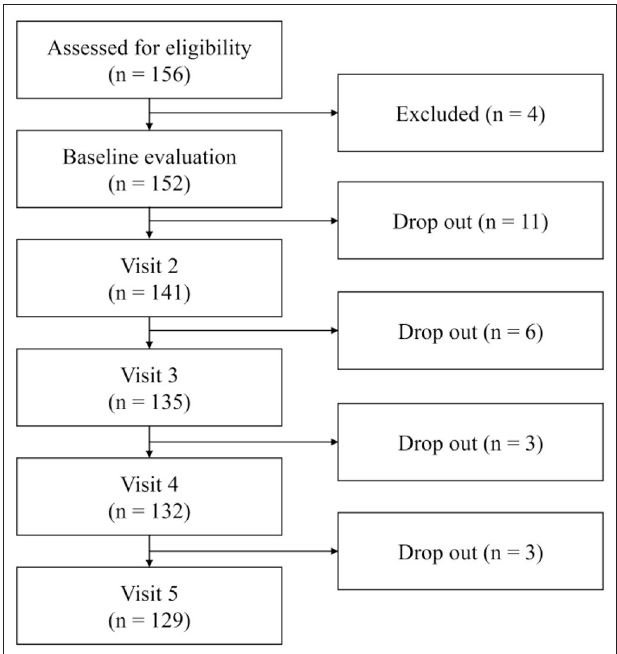
FIGURE 1 | Flowchart of study inclusion from baseline visit to visit 5.